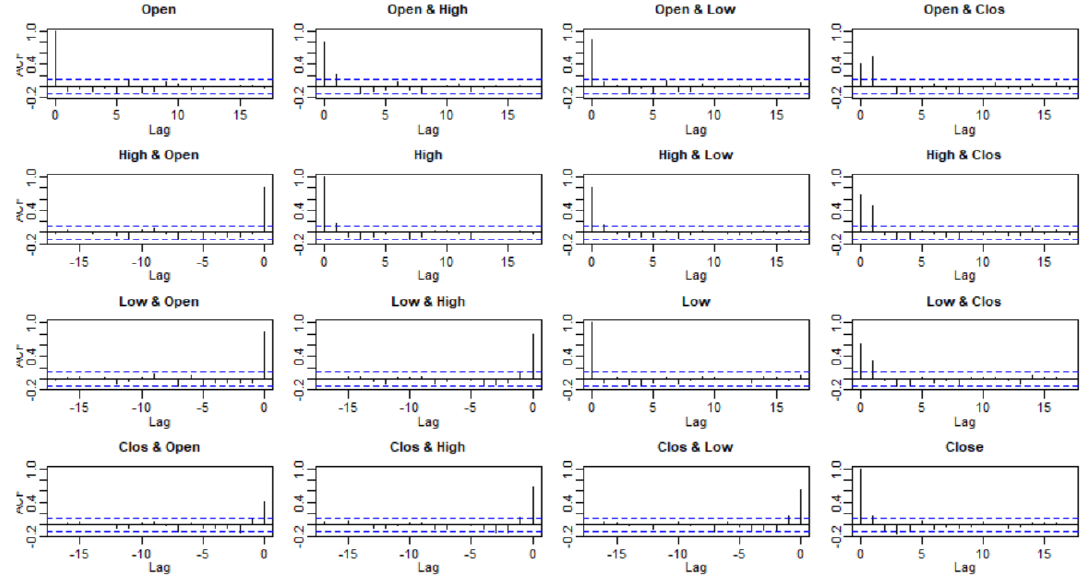
Figure A2. ACF test for correlation between open, low, high, and close of Facebook stock daily returns